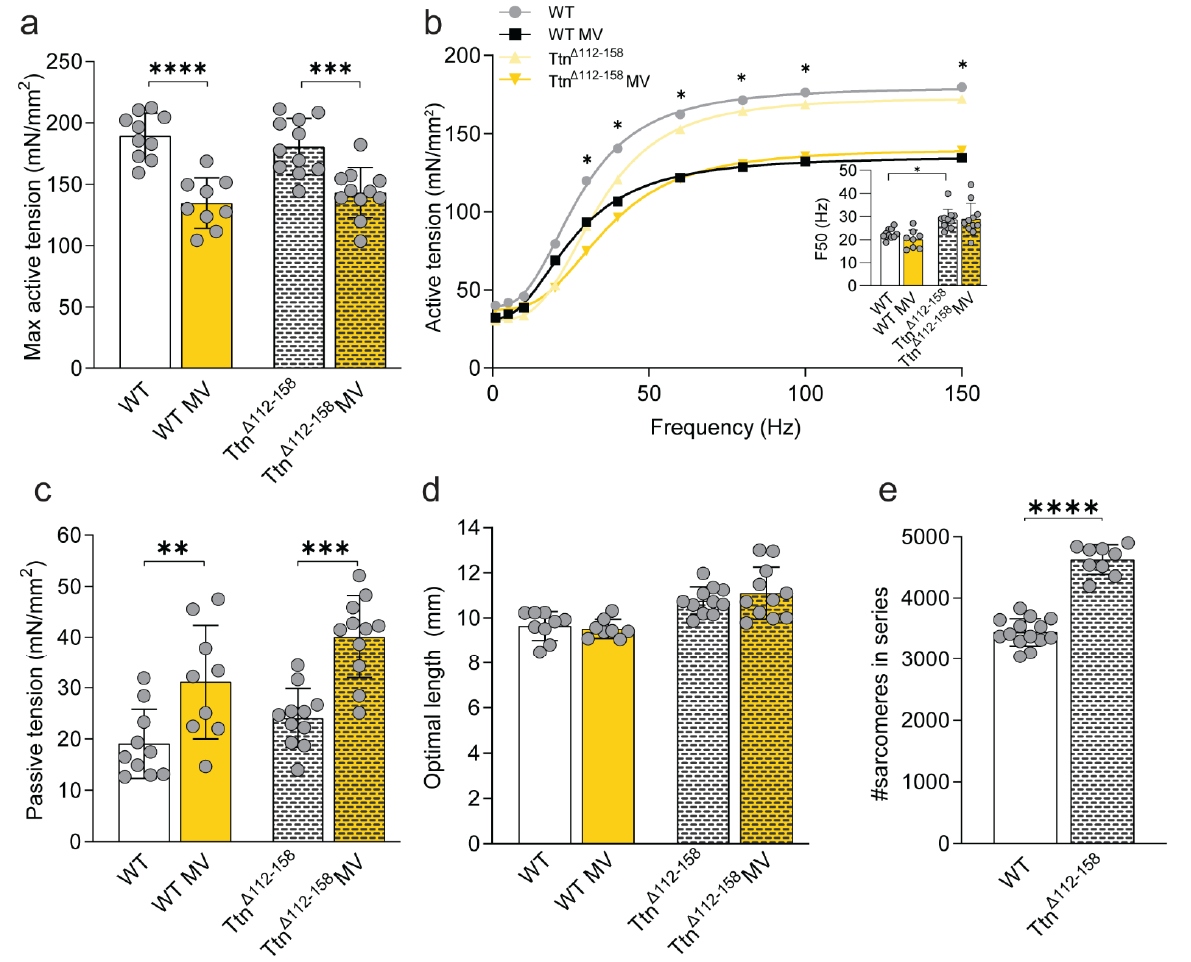
Figure 4. Effects of mechanical ventilation on muscle function in the Ttn Δ 112 − 158 mouse diaphragm. ( a ) Maximal active tension of non-ventilated and ventilated WT and the Ttn Δ 112 − 158 mice. ( b ) Fitted curves for tension-stimulation frequency relations. F50 (inset) was determined as the absolute EC50 of the curve, and represents the frequency required to develop 50% of maximal force. Asterisks indicate a significant reduced force in mechanical ventilated animals compared to their respective non-mechanically ventilated controls. ( c ) Passive tension measured at optimal length in non-ventilated and ventilated WT and Ttn Δ 112 − 158 mice. ( d ) Optimal diaphragm strip length, i.e., the length representing maximal cross bridge binding required for maximal force production. ( e ) Number of sarcomeres in series. Bars represent mean ± SD. * p < 0.05, ** p < 0.01, *** p < 0.001, **** p < 0.0001. WT = wild type, MV = mechanically ventilated. Each dot represents a single animal and animals are only presented in each graph once.